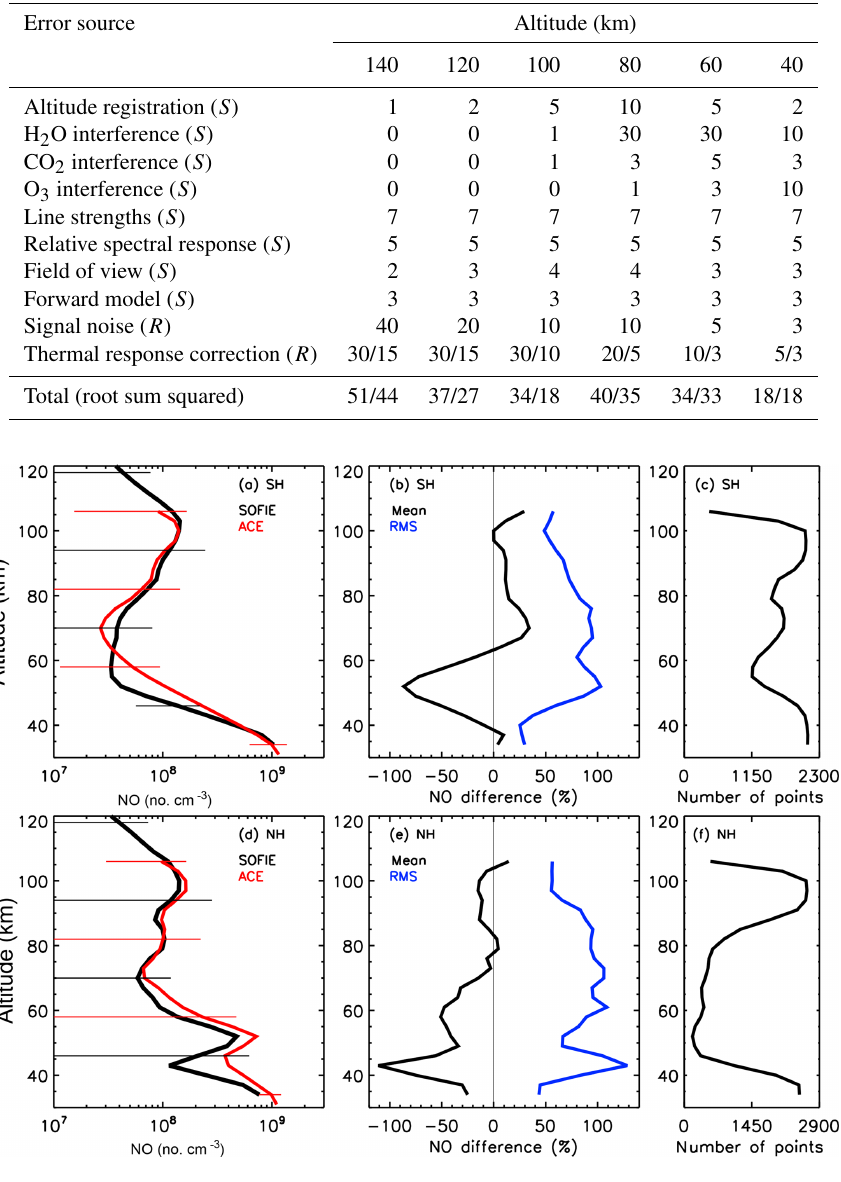
Figure 7. Comparison of SOFIE and ACE NO number density profiles, for the coincidences shown in Fig. 5. Comparisons in the SH (SOFIE spacecraft sunset; local sunrise) as (a) average profiles, (b) mean and rms differences, and (c) number of points in the comparison at each altitude. Comparisons in the NH (SOFIE sunrise; local sunset) as (d) average profiles, (e) mean and rms differences, and (f) number of points in the comparison. Horizontal lines on the average NO profiles indicate standard